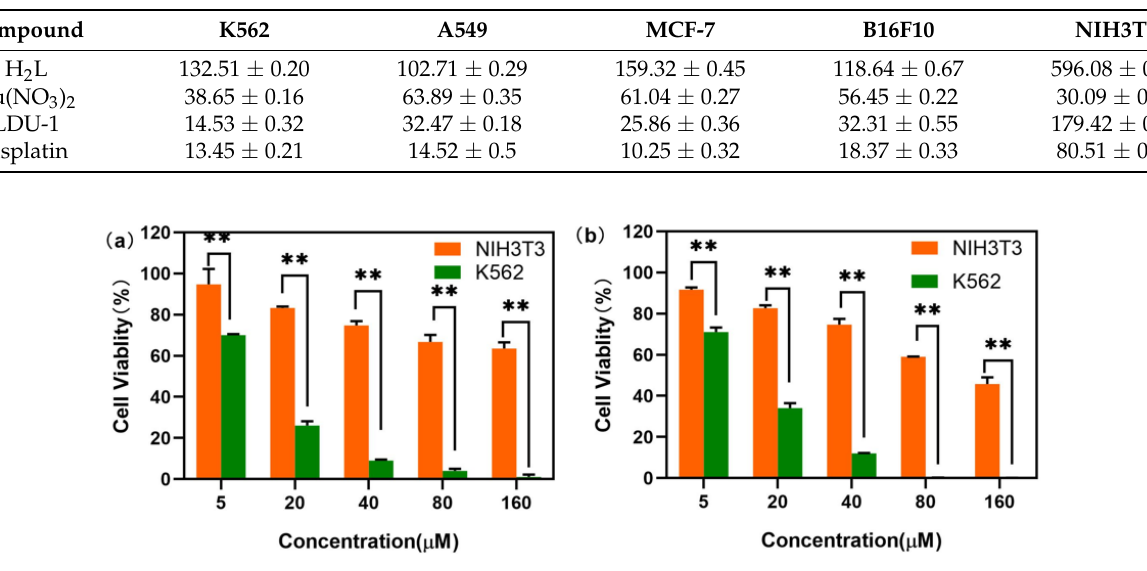
Table 4. proportion of tumor cells in cell cycle (%). Table 3. IC 50 ( µ M) for test compounds.